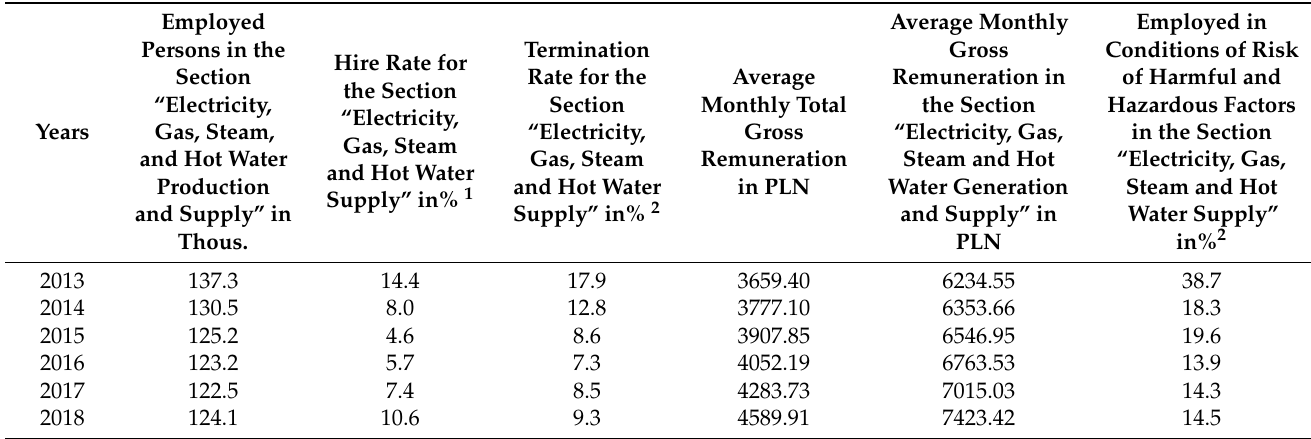
Table 6. Energy section—the context of the labor market.